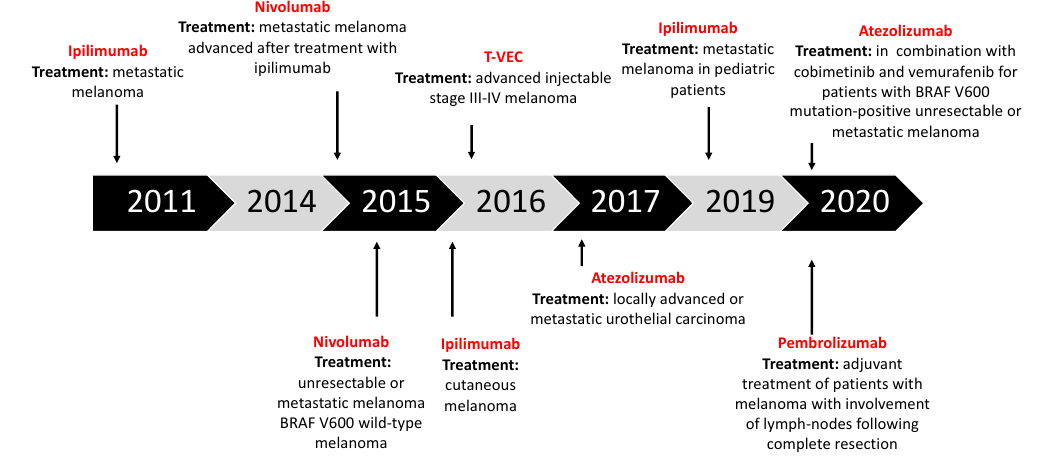
Figure 2. Timeline of immuno-oncology (IO) agents approved for cancer therapies.